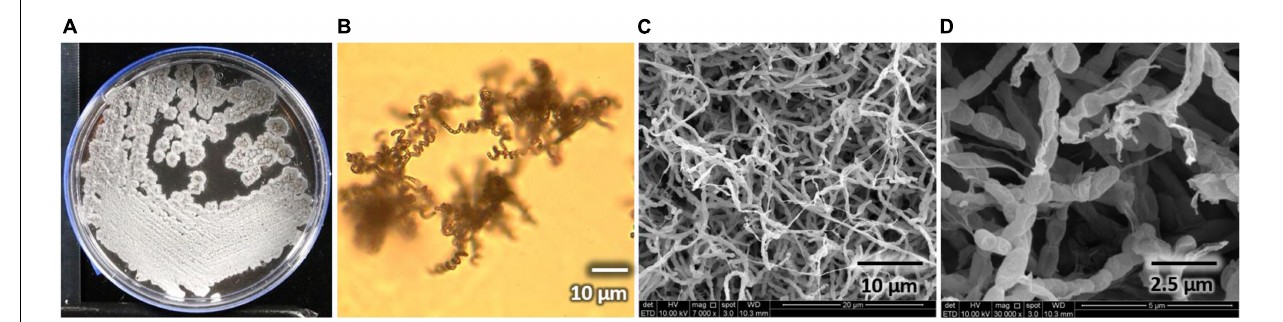
FIGURE 1 | Streptomyces sp. AC04842 morphology. (A) Surface colony morphology on yeast malt extract (ISP2) agar; (B) spore-forming structures viewed using a light microscope at 750 × magnification on soil extract agar (SEA); (C) abundant and long spore chains were observed using a SEM (SEM Quanta FEG 650); (D) chains of smooth, oblong spores were seen using a SEM (SEM Quanta FEG 650).